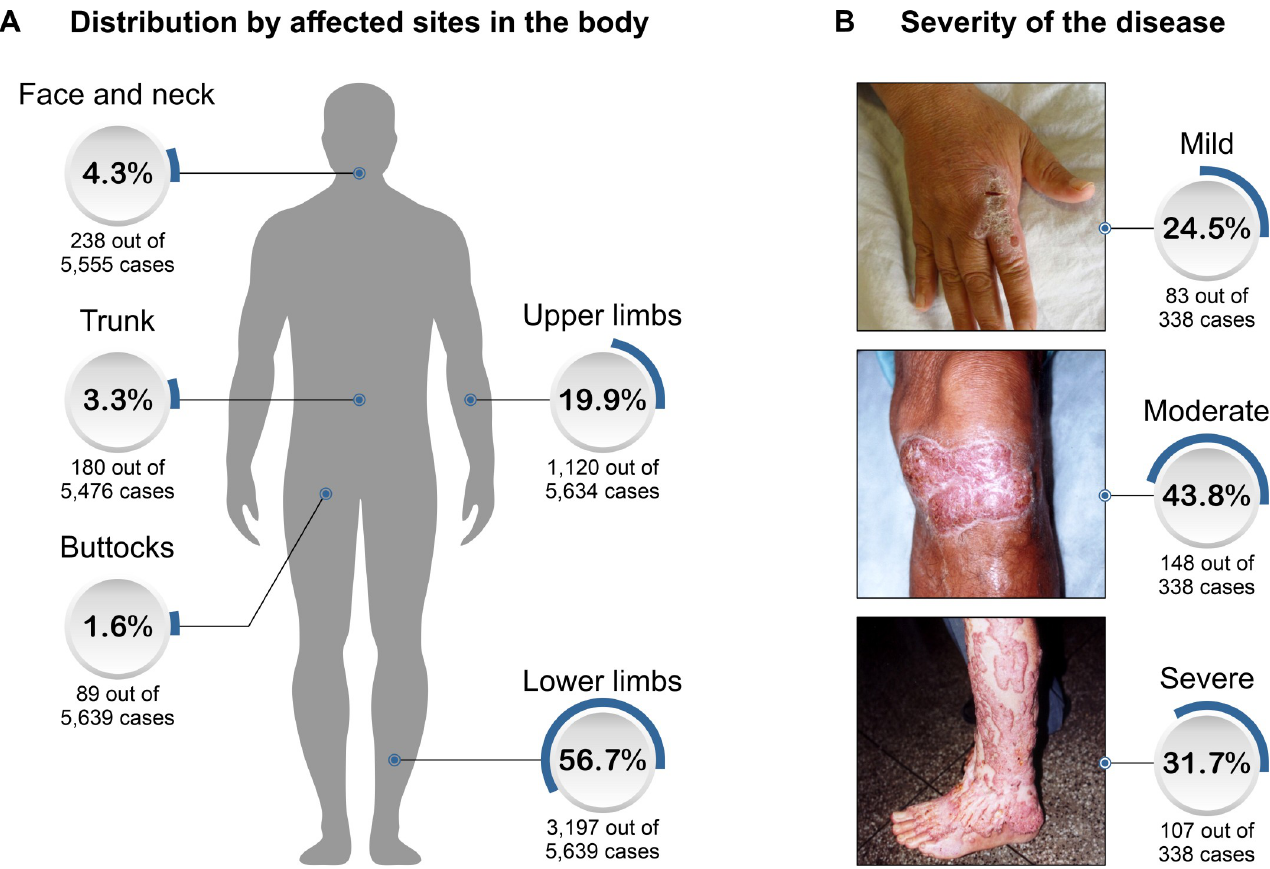
Fig 3. The chromoblastomycosis lesion site. A- The percentage of cases reported from a certain body site is shown. For lower limbs, lesions were described in 3,197 (56.7%) out of 5,639 patients; for upper limbs in 1,120 (19.9%) out of 5,634 patients; for the face and neck in 238 (4.3%) out of 5,555 patients; for the trunk in 180 (3.3%) out of 5,476 patients described; and finally for the buttocks in 89 (1.6%) out of 5,639 patients described. Unusual sites such as ear, breast, inguinal region were reported in 61 cases. B—Percentage of lesion